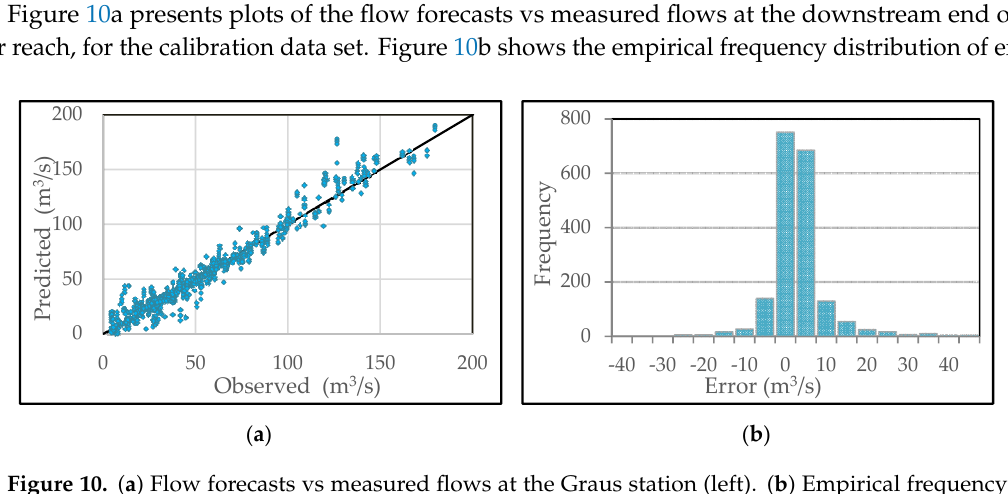
( b ) Figure 11. ( a ) Flow forecasts vs measured flows at the Graus station. ( b ) Empirical frequency distribution of the errors (validation data set). Results concerning the flow peak forecasts are presented in Table 7 and Figures 12 and 13. Table 7. Error statistics estimated over a selected family of peak flows in both samples. Average